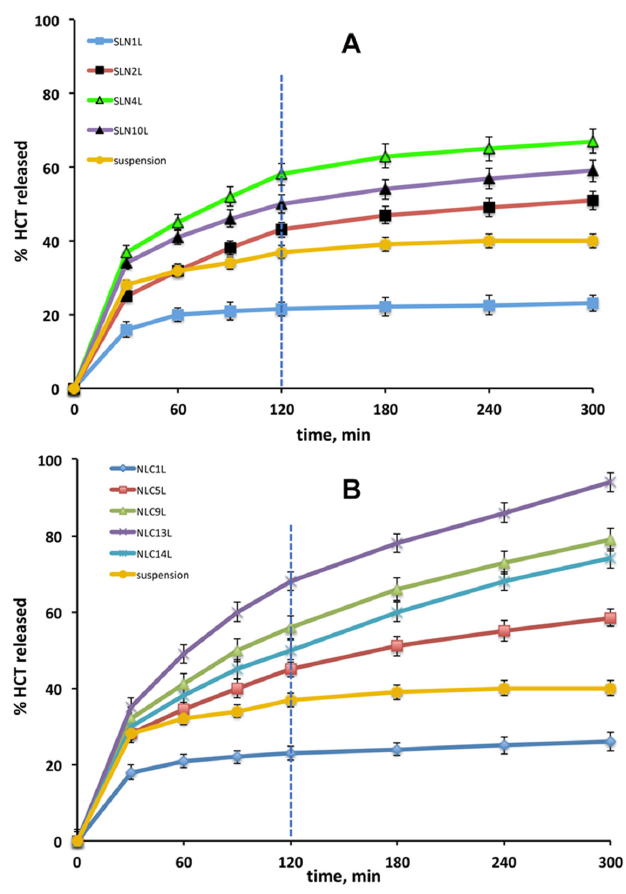
Figure 4. HCT release curves from the selected SLNnL ( A ) and NLCnL ( B ) formulations, at 37 °C for 2 h in pH 4.5 and 3 h in pH 6.8, together with that of the simple HCT suspension as reference.